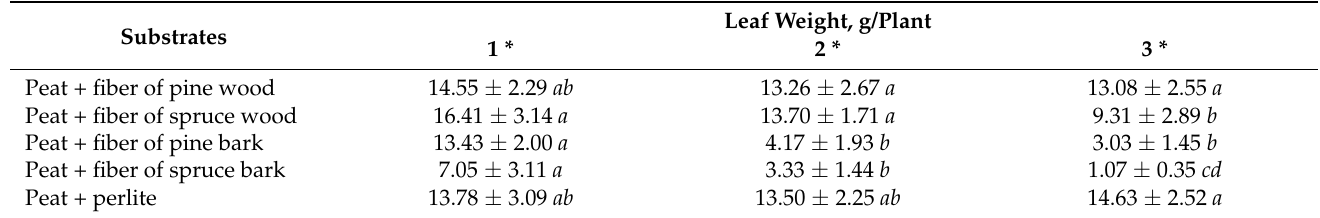
Table 4. Effect of mixes of peat with different amounts of wood and bark fibers and perlite on the leaf weight of blueberry